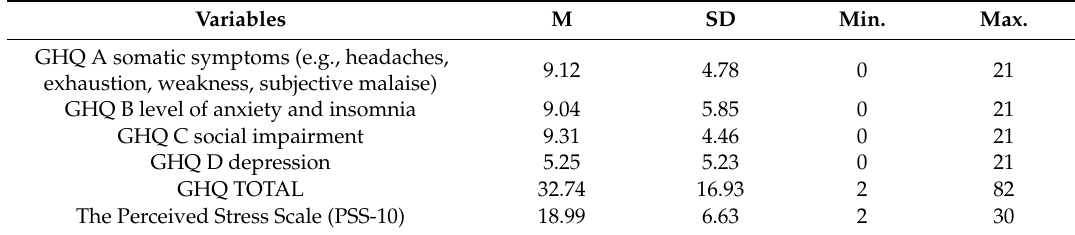
Table 4. The state of mental health and the level of perceived stress in the study group ( N = 443). Variables M SD Min.